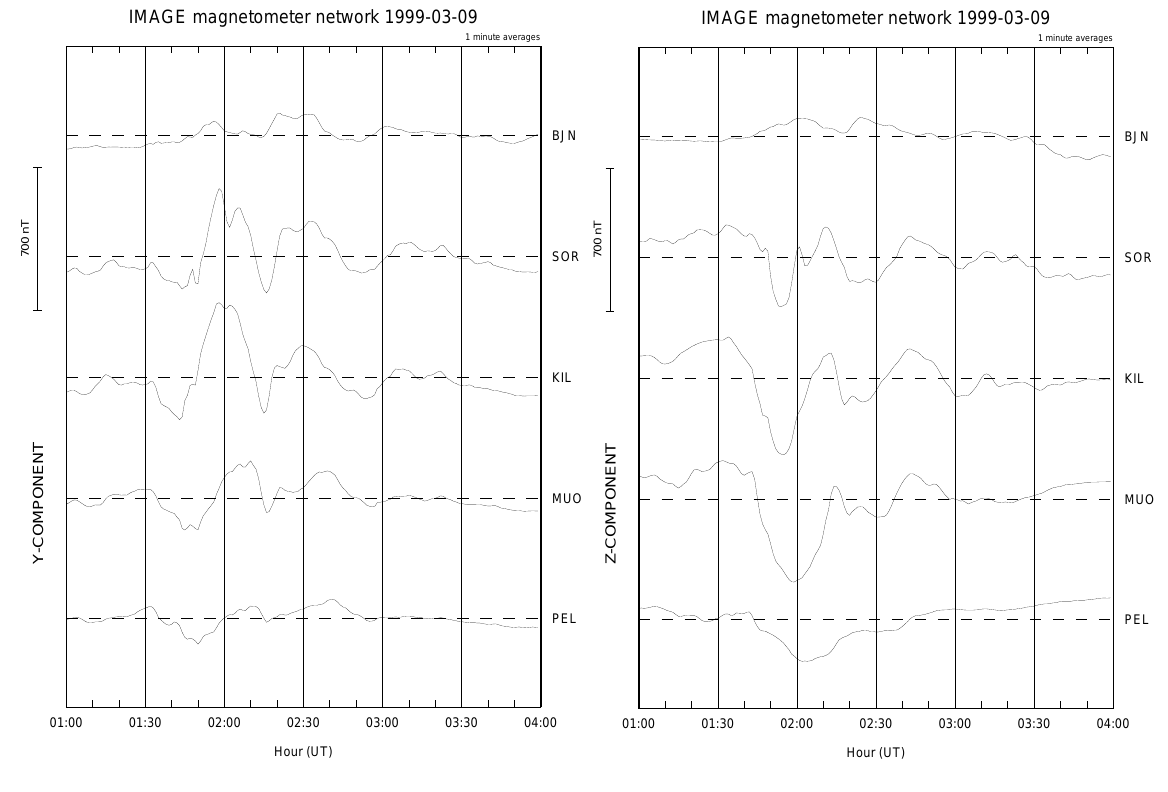
Fig. 4. Magnetogram showing the disturbance in the eastward (Y) and downward (Z) components of the ground magnetic field at selected IMAGE